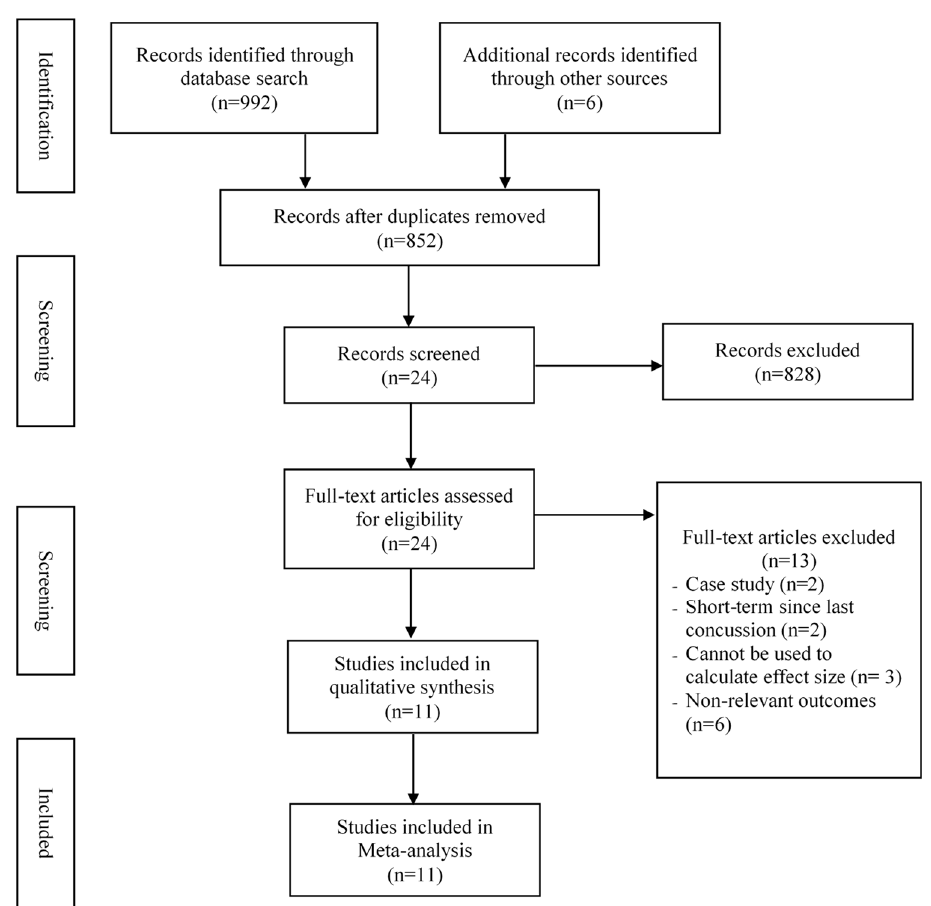
Figure 1. Flowchart of the study selection.